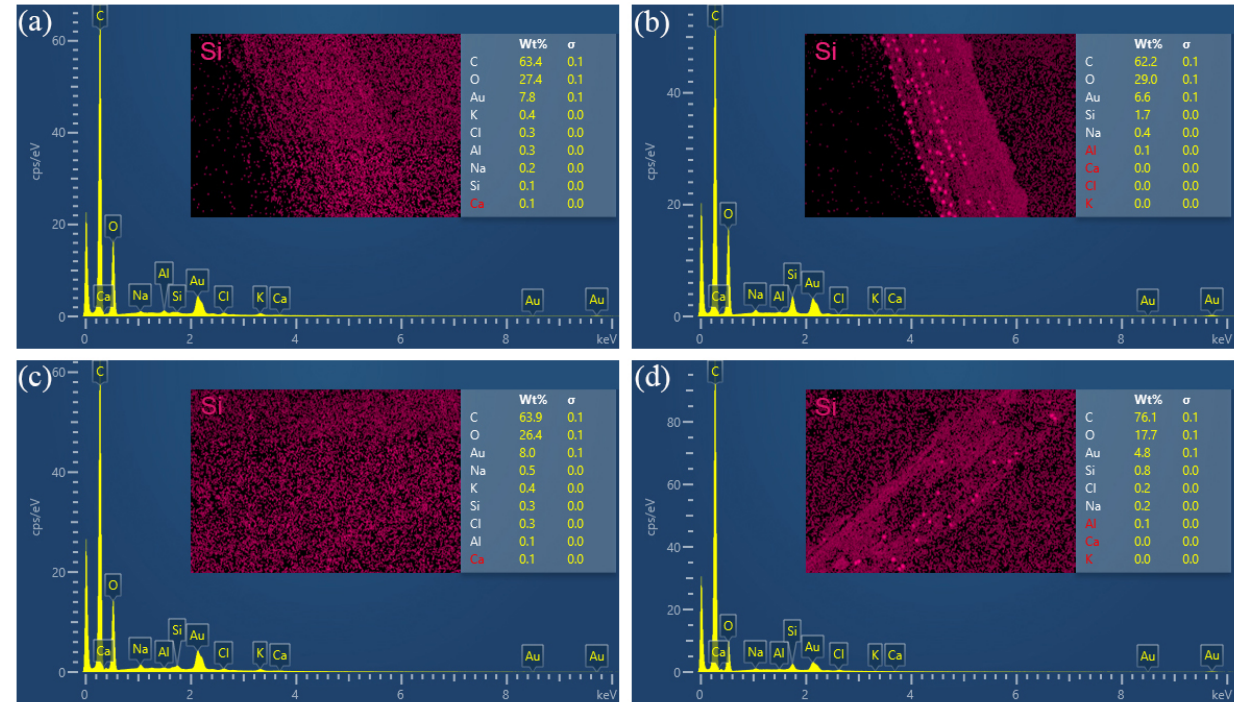
Figure 10. The percentage content of each element and the distribution of Si element: ( a ) U-CF, ( b ) A-S-CF, ( c ) Matrix of U-CFPS, ( d ) Matrix of A-S-CFPS.